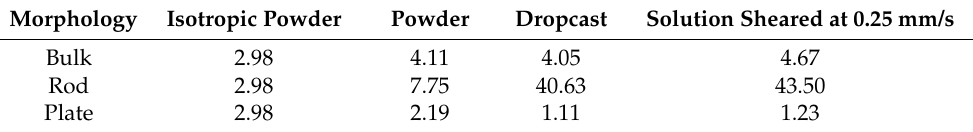
Table 5. Orientation number for different morphologies for different film deposition techniques, where orientation number is the ratio of (110)/(001) peak intensities for each XRD. An orientation number of 2.98 represents a uniformly isotropic powder. PXRD patterns of sheared samples can be found in supplemental materials (Figure